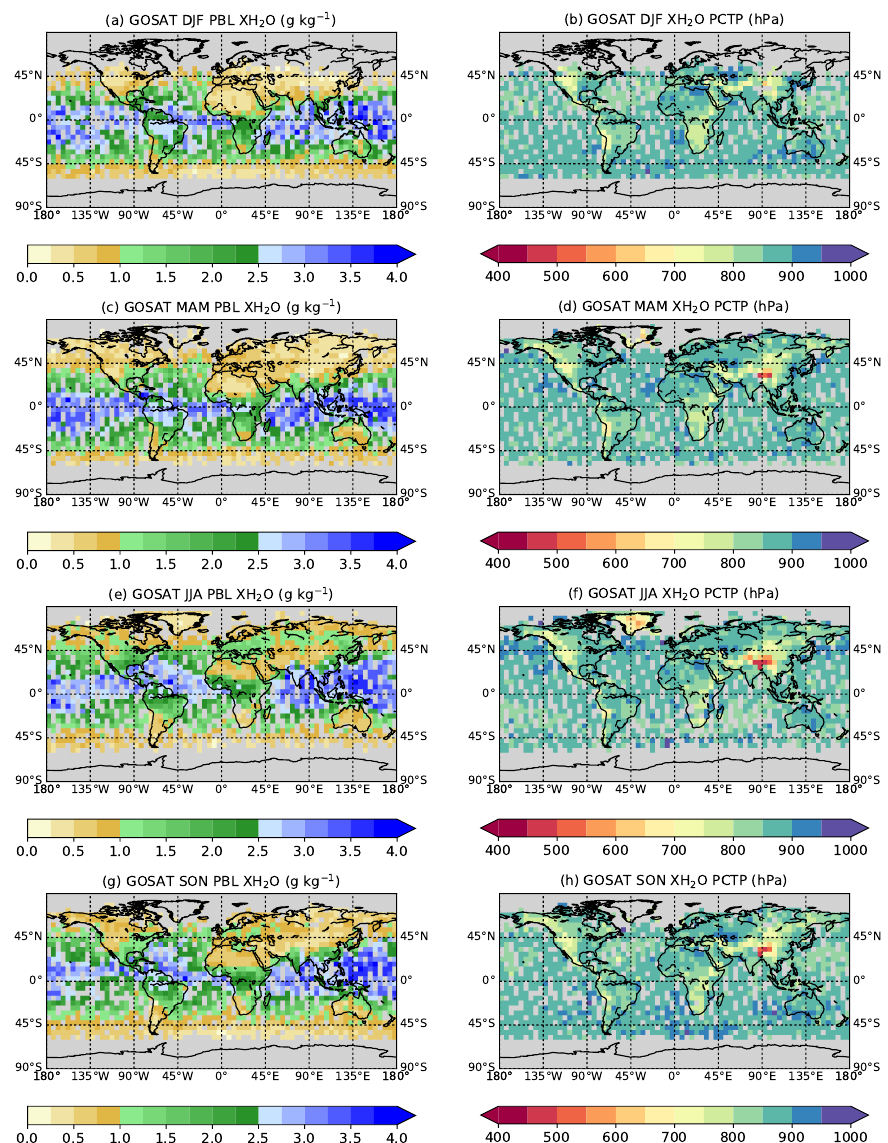
Figure 7. Seasonal distribution of GOSAT PBL XH 2 O for northern hemisphere ( a ) winter—December, January and February, ( c ) spring—March, April and May, ( e ) summer—June, July and August, and ( g ) autumn—September, October and November. The corresponding mean seasonal PBL partial column top pressure (PCTP) level values are also shown ( b , d , f , h ). Seasonal plots are based on mean values from December 2016 to November 2017, and are binned in to 5 ◦ × 5 ◦ averages. The variable spatial sampling of GOSAT introduces a strong seasonal signal, especially over sun glint